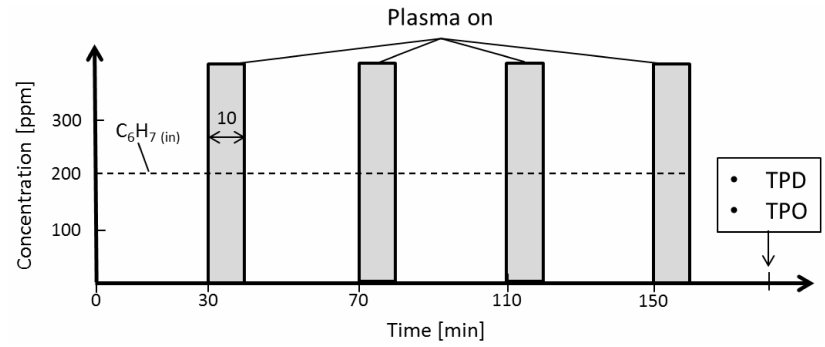
Figure 10. Plasma cyclic